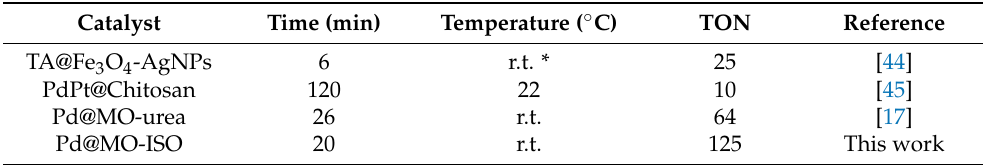
Table 1. Comparing the PNP reduction through our synthesised catalyst with the previously reported catalysts in aqueous solution in the presence of NaBH 4 as reducing agent.